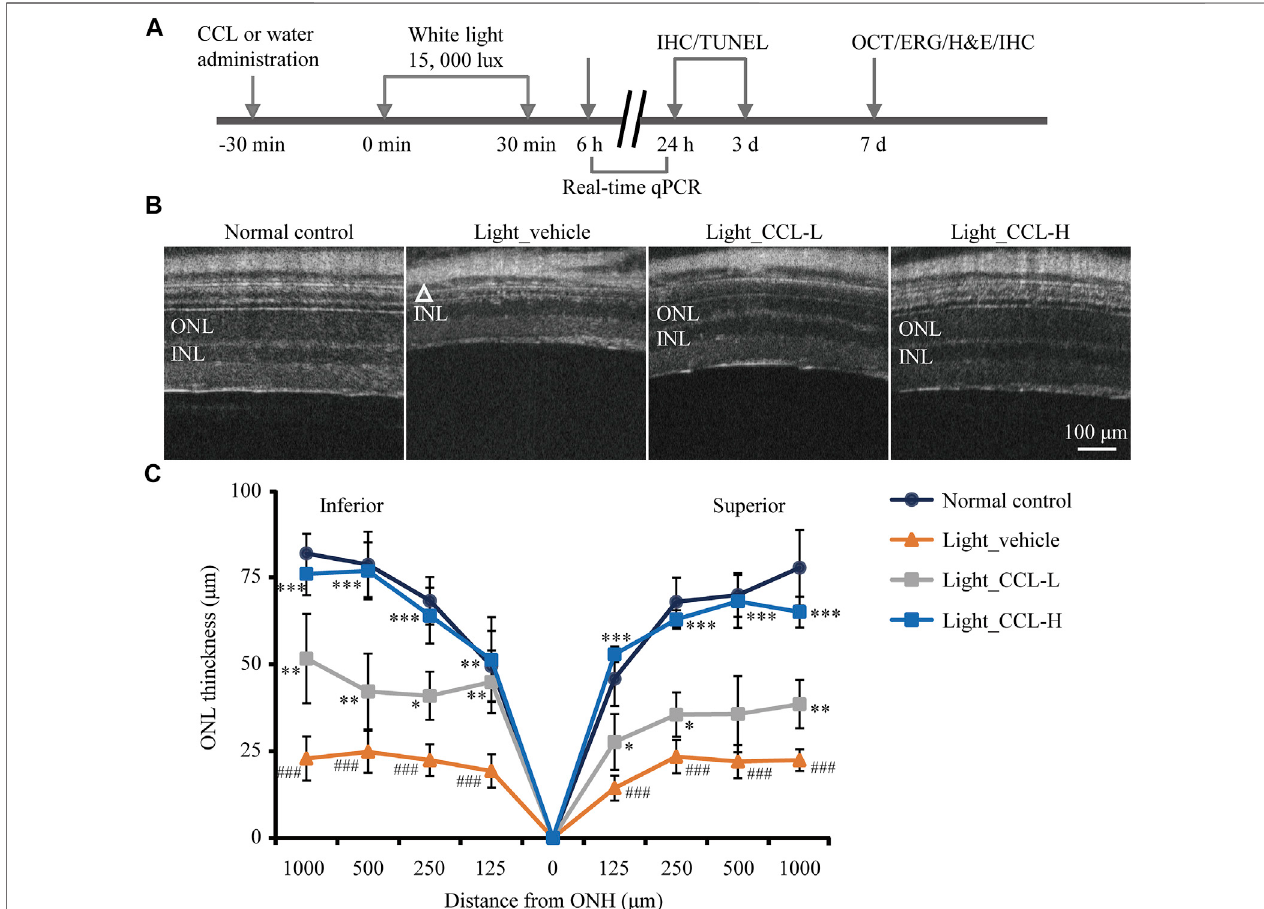
FIGURE 2 | CCL protects against light-induced impairment of the photoreceptor structure. (A) The schematic drawing of the experimental design. BALB/c mice were pretreated with CCL or water. Thirty min later, the mice were exposed to white light at 15,000 lux for 30 min, followed by the indicated assessments. (B) OCT imagingwascarried out7 days afterlightexposure toobtainthefull-retinalstructuralimages. (C) ONLthicknesswasmeasured at125,250,500and1,000 μ moffONH in the inferior and superior retinas. The white triangle signi fi es the damaged ONL. INL, inner nuclear layer; ONH, optic nerve head; ONL, outer nuclear layer. Scale bar, 100 μ m. Data were expressed as mean ± SD (n = 5 per group). ### Compared to Normal control, p < 0.001; * compared to Light_vehicle, p < 0.05; ** compared to Light_vehicle, p < 0.01; *** compared to Light_vehicle, p <